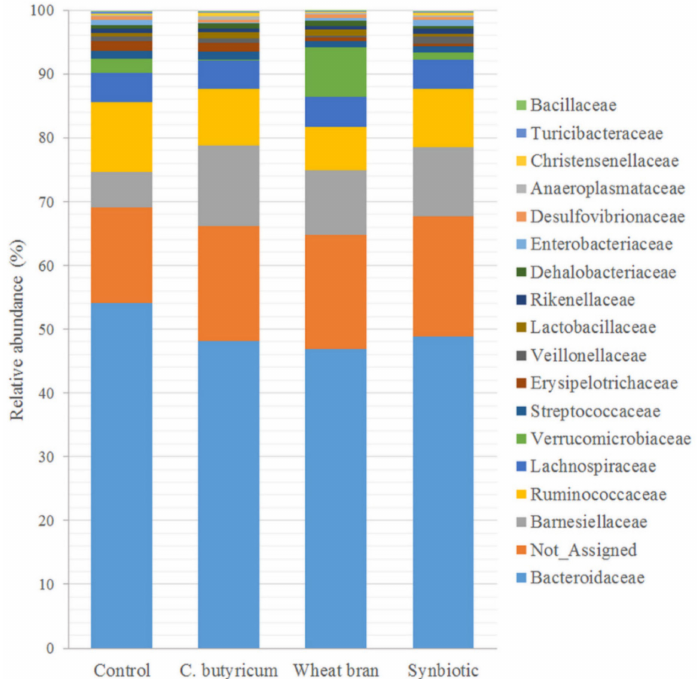
Figure 3. Relative abundances of bacteria at the family level in the cecal content of chickens fed control (C), Clostridium butyricum supplemented ( C. butyricum ), wheat bran supplemented and Clostridium butyricum + wheat bran supplemented (SYN) diets (day 37 of